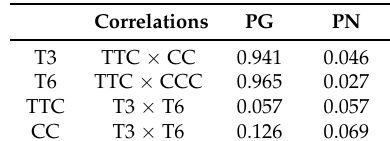
Figure 10 . Punicalagin ( a ) and punicalin ( b ) contents in PGHF; HGT3TTC-hydrogel, time: 3 months, temperature test chamber; HGT6TTC-hydrogel, time: 6 months, temperature test chamber; HGT3CC -hydrogel, time: 3 months, climate chamber; HGT6CC-hydrogel, time: 6 months, climate chamber. Results are represented by means ± S.E.M. ( n = 3). No statistical significant difference was detected. Statistical analysis was performed by two-way ANOVA followed by Bonferroni’s test of multiple comparisons ( p < 0.05). Table 2. Determination of significance levels when comparing correlations between PGHF, biomarkers, time and storage conditions after ANOVA.